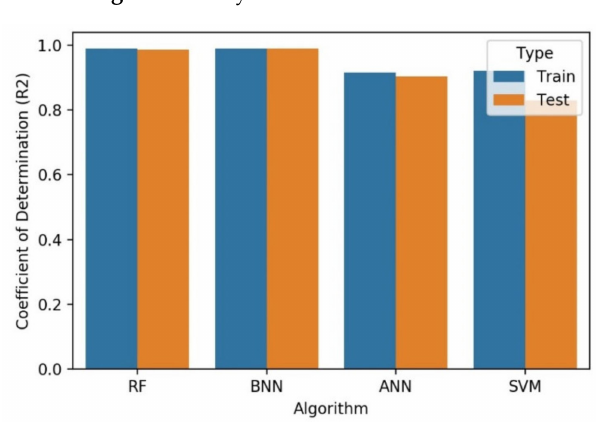
Figure 9. Analysis of mean absolute error.